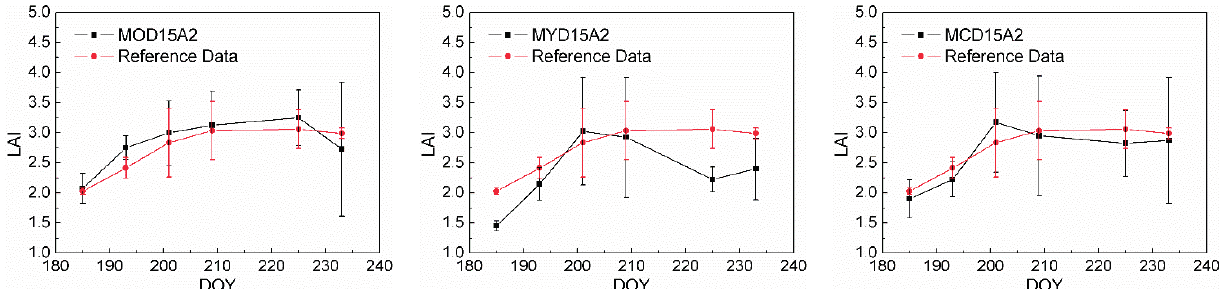
Figure 11. Time series comparison between the mean of the LAI reference maps at Huailai site and the corresponding LAI of the three MODIS products from 4 July to 28 August 2013. The error bars represent the standard deviation of the four pixels at Huailai site from the MODIS LAI products ( black ) and the LAI reference maps ( red ).